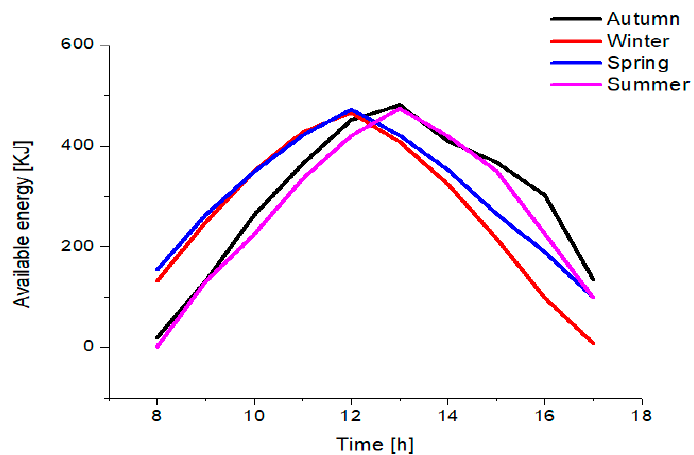
Figure 7. Comparison of available energy on receiver per season in static setup (21°).